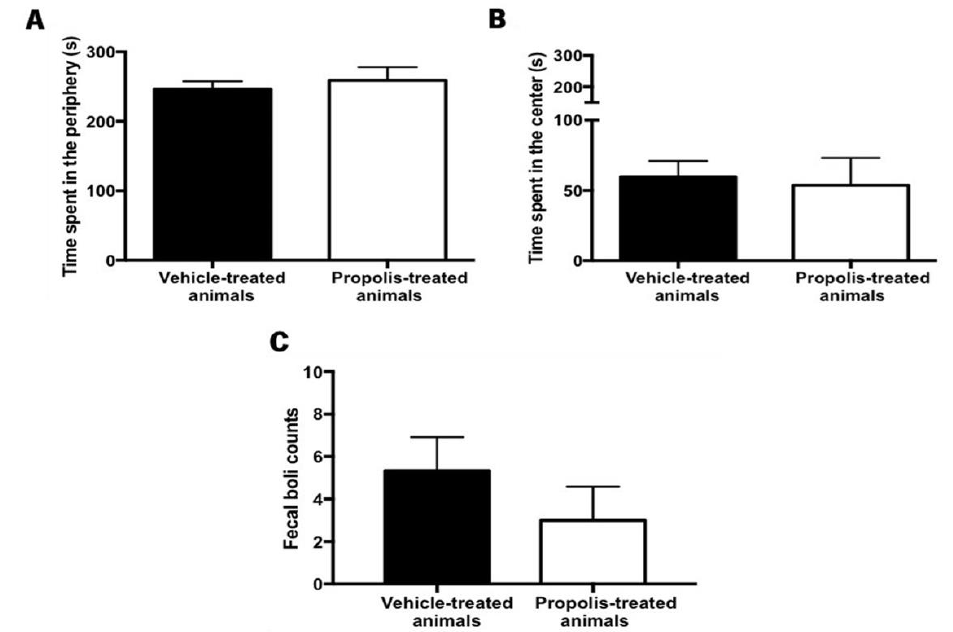
Figure 9. Evaluation of the anxiety-like behavior after propolis administration in the vehicle and propolis-treated animals. This parameter was evaluated using the OF test. Time spent ( A ) in the periphery and ( B ) in the center of the OF arena by the vehicle and the propolis-treated animals; ( C ) Fecal boils left in the OF arena at the end of the experimental session by the same tested group of animals. Results were expressed as mean ± SEM. ( (cid:4) —vehicle-treated animals; (cid:3) —propolis-treated animals).